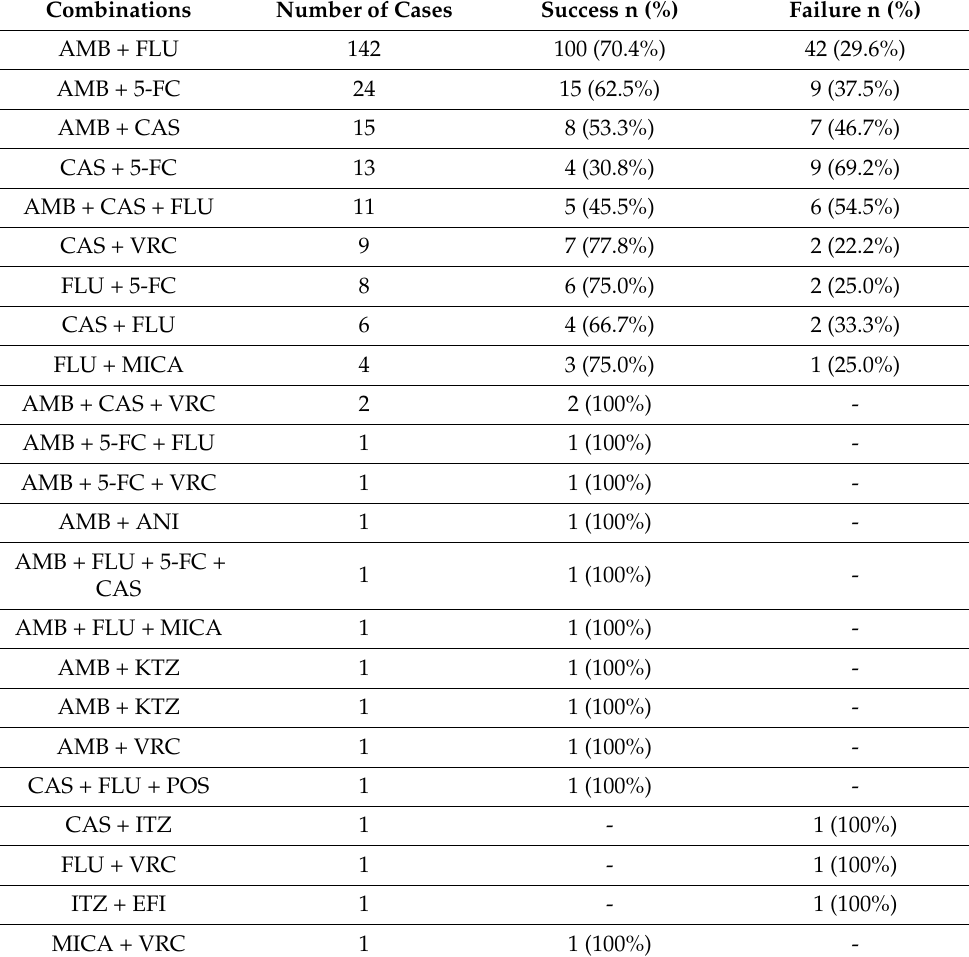
Table 3. Number and percentage of clinical success or failure of the different antifungals’ combina- tions used in case reports and clinical trials reported in the study. Combinations Number of